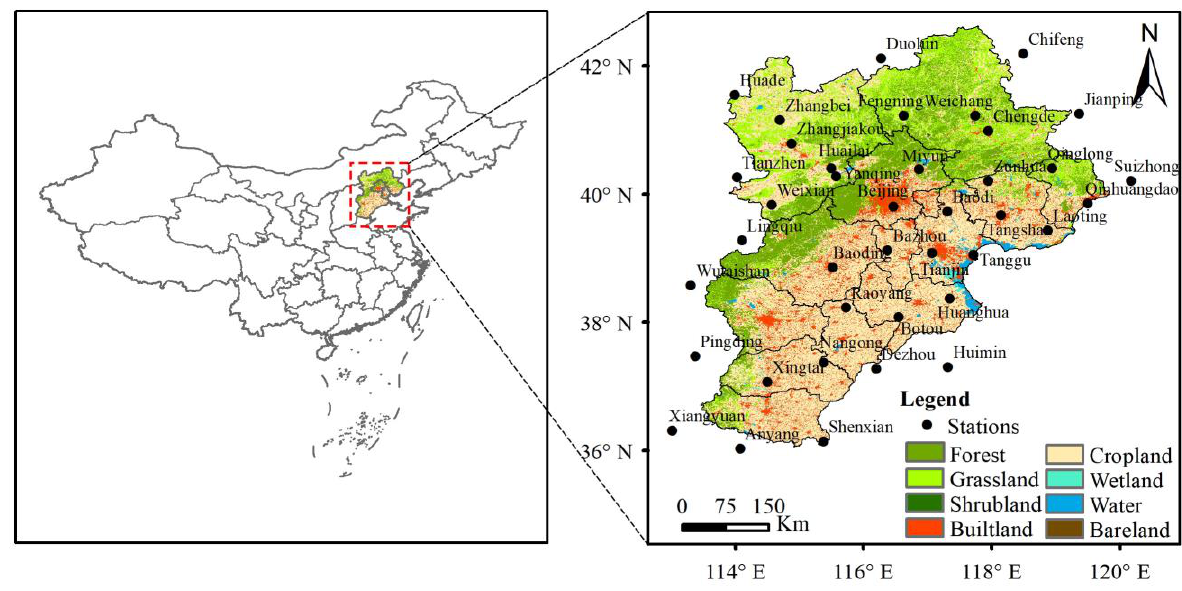
Figure 1. The location of the Beijing – Tianjin – Hebei region of China.